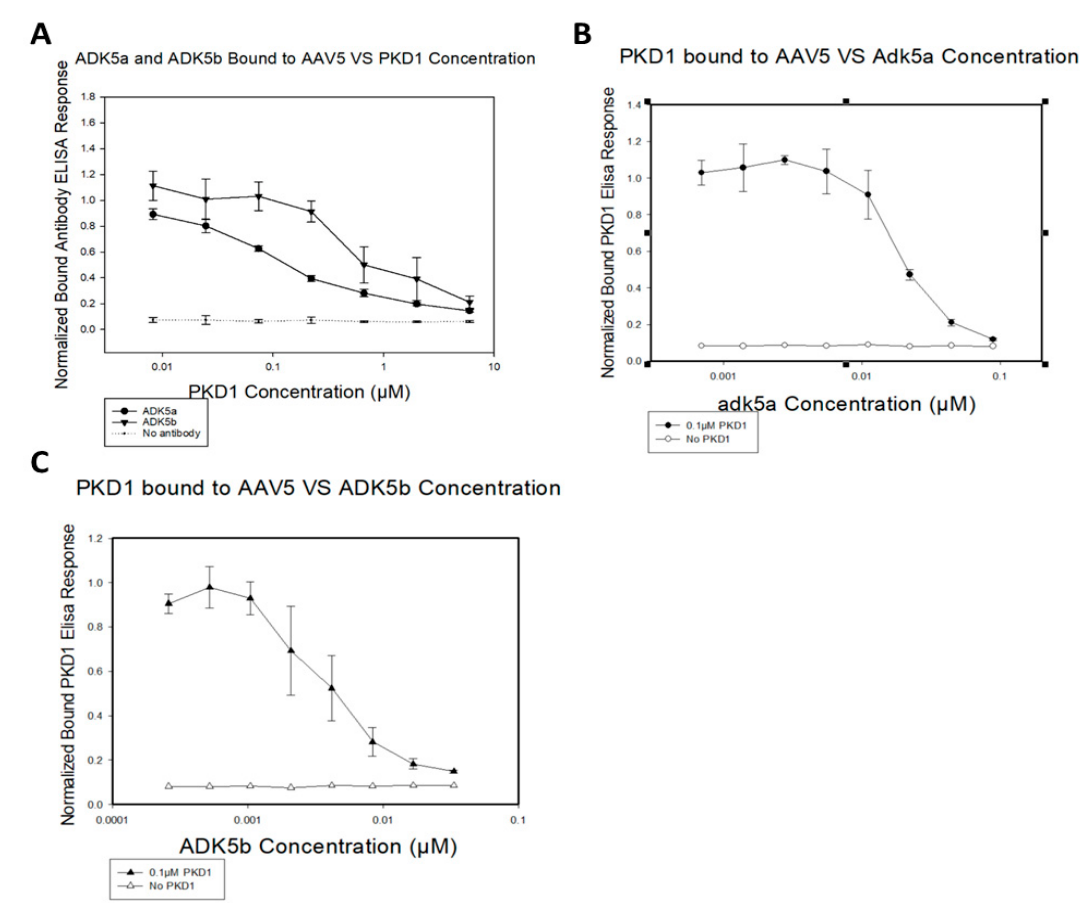
Figure 4. Competition assays of ADK5a, ADK5b, and PKD1. ( A ) ELISA of antibody binding to AAV5 with constant antibody concentration and differing levels of PKD1 concentration, performed as six replicates and normalized to a positive control without PKD1. ( B ) ELISA of PKD1 binding to AAV5 with a constant PKD1 concentration of 0.1 µ M and various levels of ADK5a performed in triplicate and normalized to a positive control without antibody. ( C ) The same as B but with ADK5b instead of ADK5a. All error bars are ± 1 standard